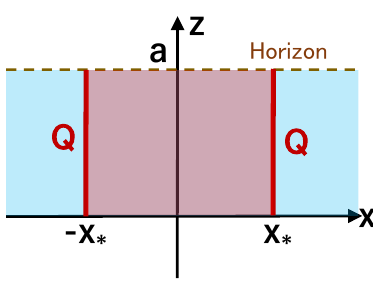
Figure 26 . A sketch of disconnected EOW branes in